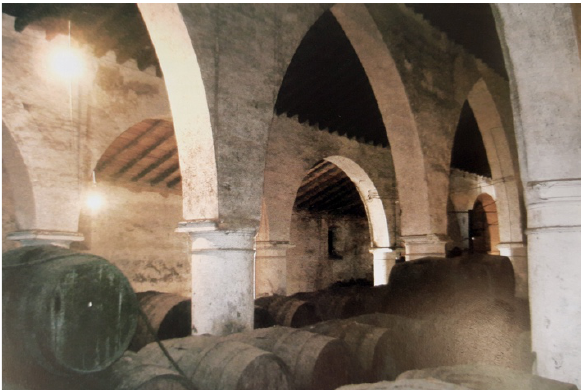
Figure 10. Winery Las Carrionas, Bollullos. (Díaz,